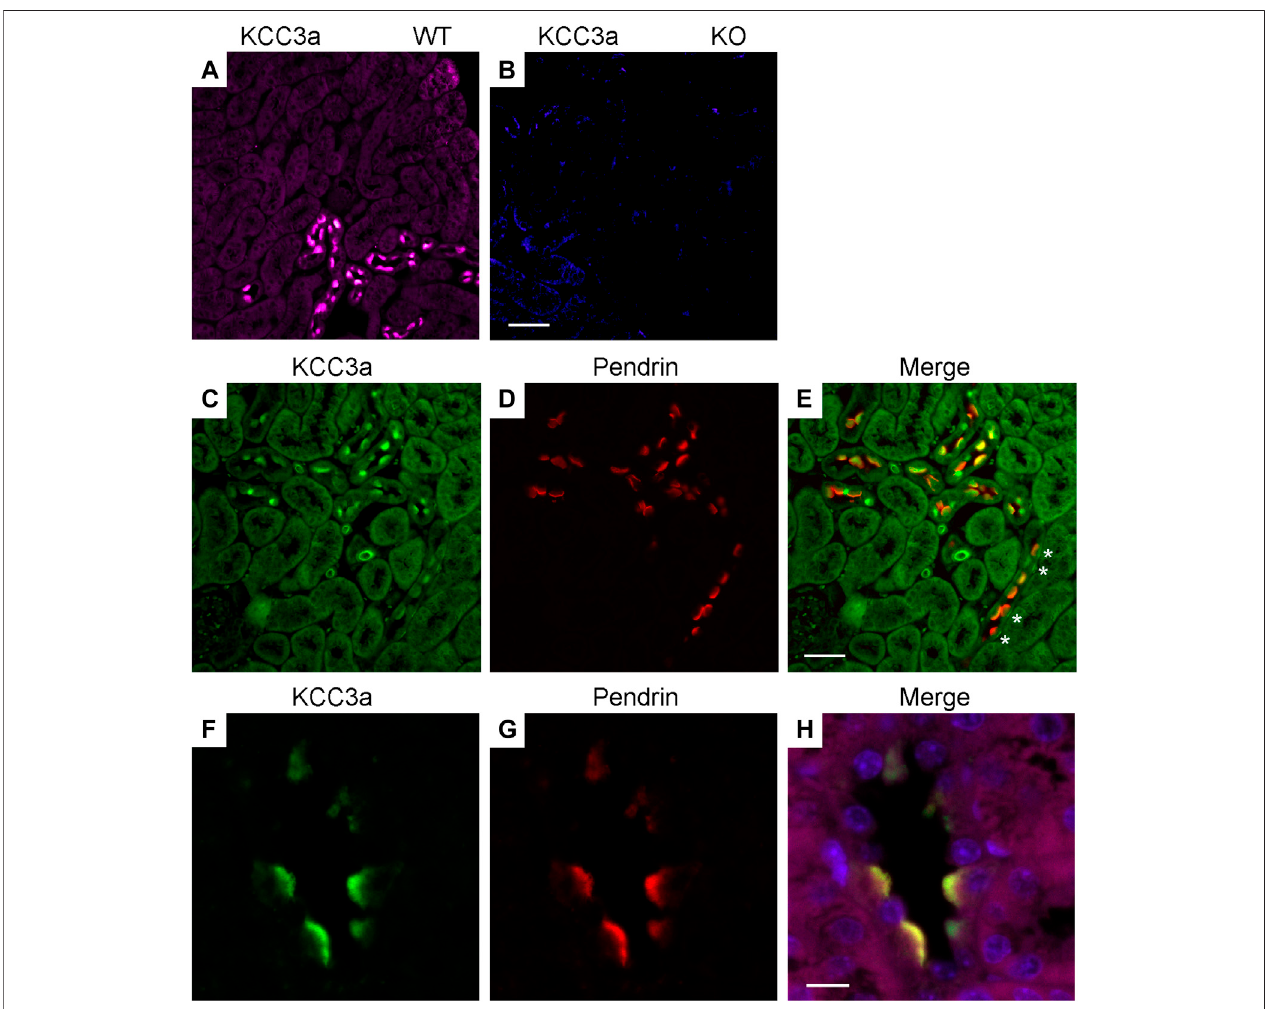
FIGURE2 | Potassium chloride cotransporter 3a (KCC3a) expression in pendrin-expressing cells. KCC3a signal (purple) inthe kidney cortexofwild-type mice (A) , but not KCC3-knockout mice (B) . KCC3a expression [green, (C) ] and pendrin expression [red, (D) ] with an overlap of signal [yellow, (E) ] in the kidney cortex at 40X. Notably, there is a presence of cells with faint basolateral KCC3a staining (white stars). Similarly, KCC3a expression [green, (F) ] and pendrin expression [red, (G) ] with overlap [yellow, (H) ] at 63X. The absence of KCC3 expression in most tubule segments surrounding the positive cells is also noted. Scale bars = 50 µm for panels (A – E) and 10 µm for panels (F – H)